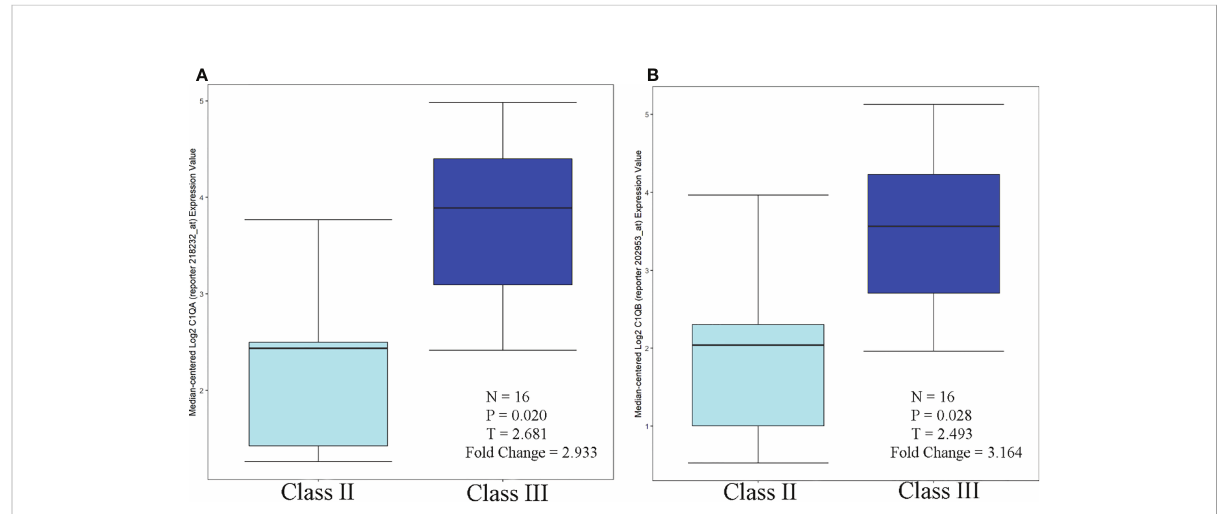
FIGURE 9 C1QA/C1QB over-expression in WHO Class III vs. WHO Class II (Lupus Nephritis Samples. (A) C1QA, (B)